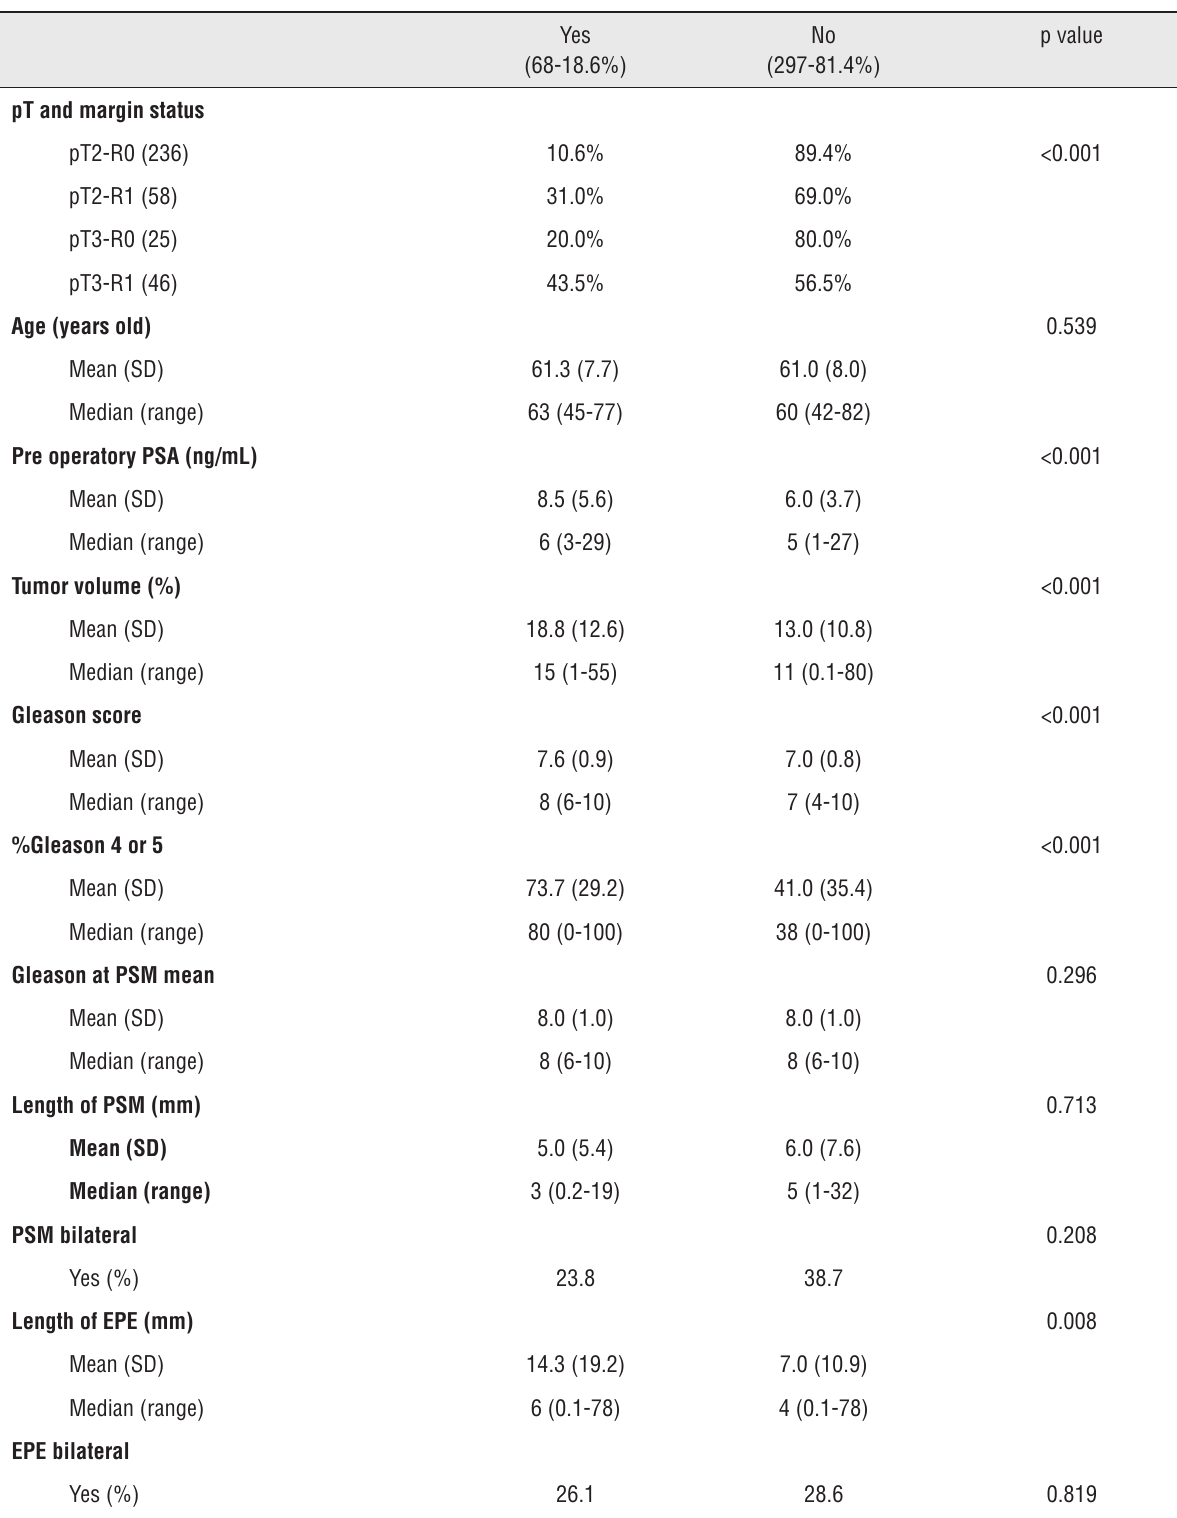
Table 2 - Univariate analysis relating biochemical recurrence with clinical and pathologic